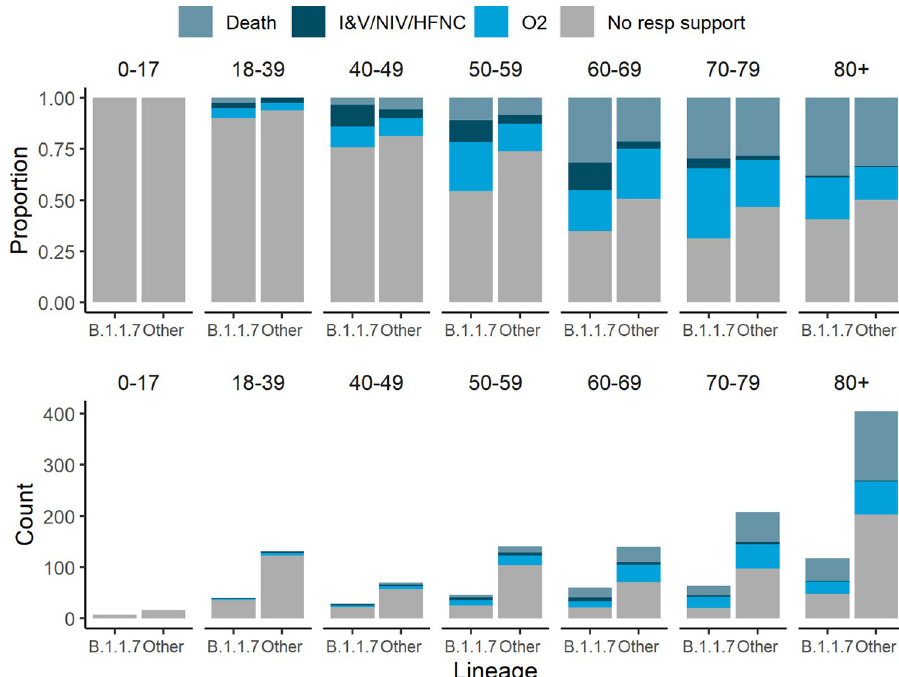
Fig 2. Comparison of disease severity between the Alpha variant (B.1.1.7) and other lineages. Clinical severity was measured on a four-level ordinal scale based on the level of respiratory support received for 1454 patients stratified by age group; death, invasive or non-invasive ventilatory support including high flow nasal cannulae (IV/NIV/HFNC), supplemental oxygen delivered by low flow mask devices or nasal cannulae, and no respiratory support.